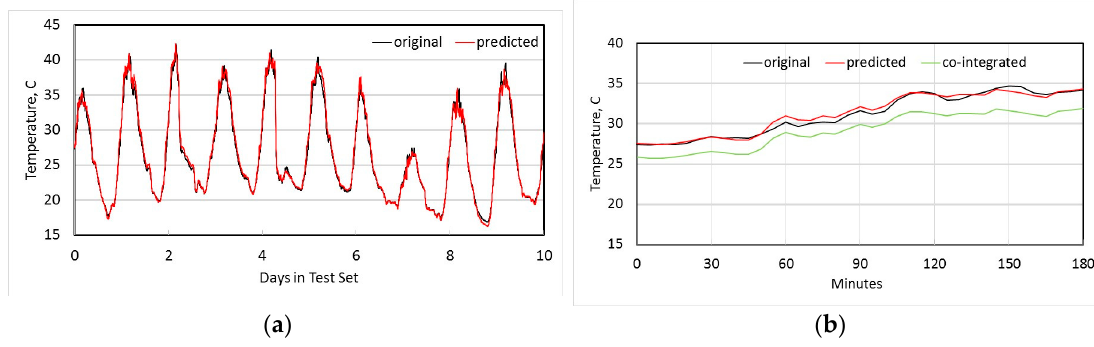
Figure 5. Estimation of temperature at node N1 using most co-integrated node N2 ( a ) over 10 days; ( b ) detail over first three hours, including the co-integrated baseline used for estimation.